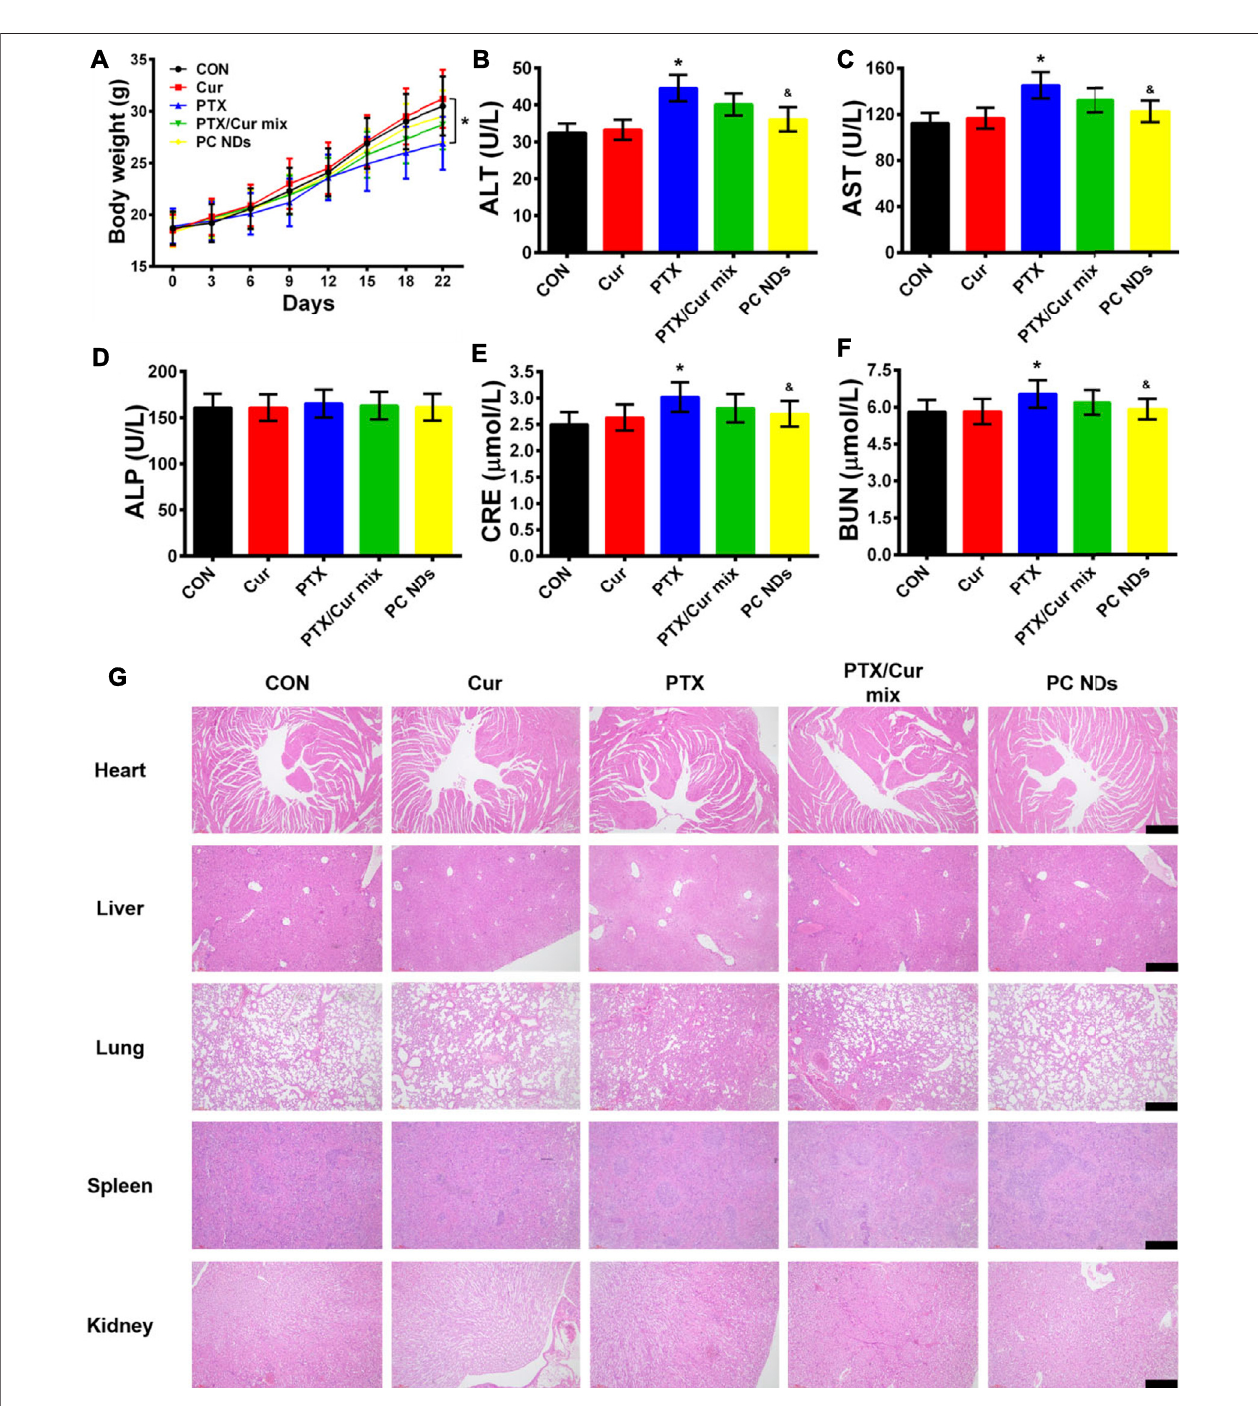
FIGURE6| Biosafetypro fi le ofPCNDs. (A) Bodyweight, (B) ALT, (C) AST, (D) ALP, (E) CRE, (F) BUN, and (G) Hand Estainingimage ofheart,liver, lung, spleen, and kidney from each group. Scale bars are 50 µm. Statistical signi fi cance: * p < 0.05 vs control and p < 0.05 vs PTX.